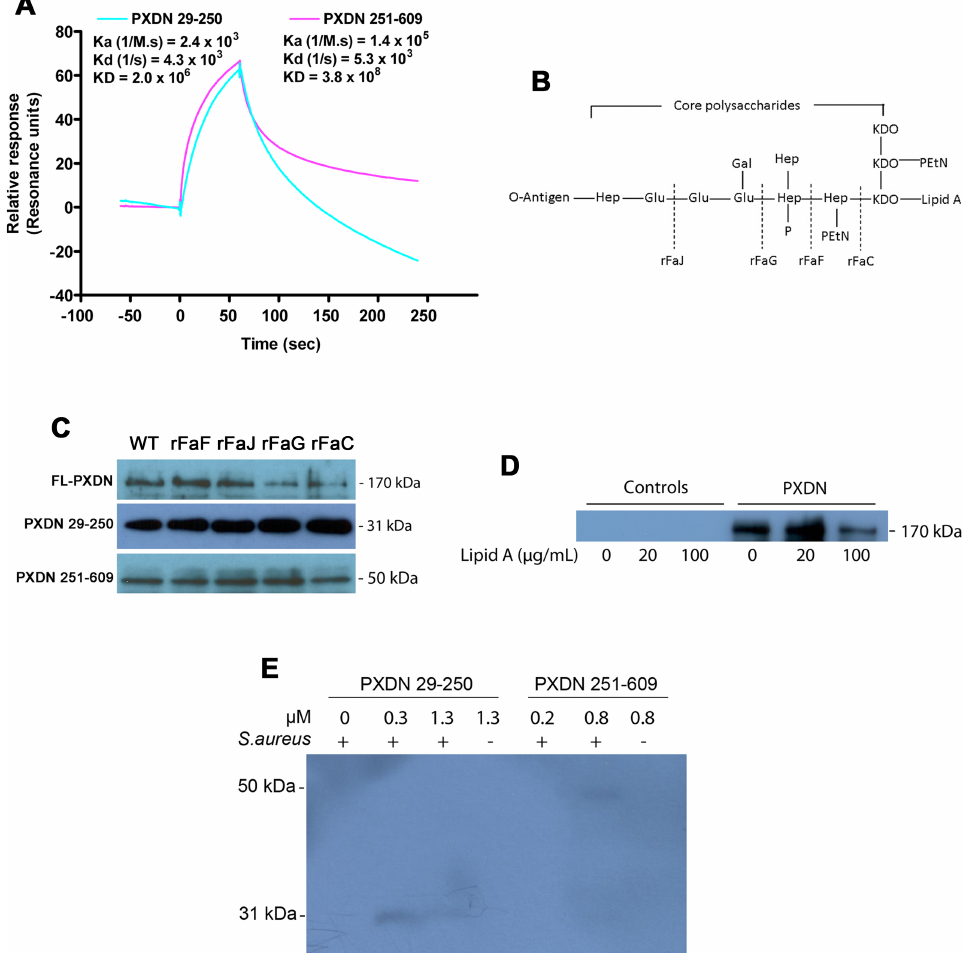
Fig 2. PXDN interacts with LPS. (A) PXDN binding to LPS determined by SPR. Recombinant peptides of PXDN 29- 250aa or PXDN 251-609aa were immobilized on a NTA chip, and LPS (2 μM) was flowed over the chip. The binding data were collected and analyzed with Biacore T200 software. Data are the representatives of three independent experiments. (B) The typical structure of E . coli LPS and genes determining the biosynthesis of LPS. Dash indicates the stage point of LPS synthesis by the corresponding gene. KDO, 3-deoxy-D-manno-oct-2-ulosonic acid; Hep, L-glycero- D-manno-heptose; EtN, ethanolamine; Gal, D-galactose; Glu, D-glucose; P, phosphate. (C) Interaction of PXDN with LPS-deficient strains of E . coli . The binding experiments of truncated PXDN to LPS-deficient E . coli strains were carried out as in Fig 1B and 1E. 100 nM of FL-PXDN or truncated PXDN were utilized. rFaF , rFaJ , rFaG and rFaC are the LPS- deficient E . coli strains with mutation of related gene. “WT” is wild-type of E . coli K12 BW25113, which is the parent strain of LPS-deficient E . coli strains. Data are representatives of three independent experiments. (D) Lipid A inhibits PXDN binding to GN bacteria. Lipid A was mixed with E . coli K12 and PXDN similar to Fig 1B. The pellets were washed twice and subjected to immunoblotting using anti-His antibody. The data are representatives of two independent experiments. (E) The binding capacity of PXDN to GP bacteria is limit. Recombinant peptides of PXDN 29-250aa or PXDN 251-609aa were added to live bacterial suspensions of S . aureus , similar to Fig 1E. The bacterial lysates were subjected to immunoblotting using anti-His antibody and visualized by chemiluminescence. Data are representatives of three independent